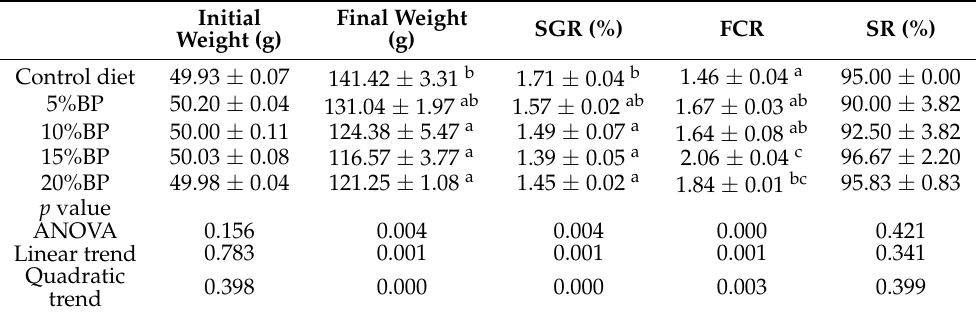
Table 3. Growth performance of grass carp fed a diet with paper mulberry (BP) for 8